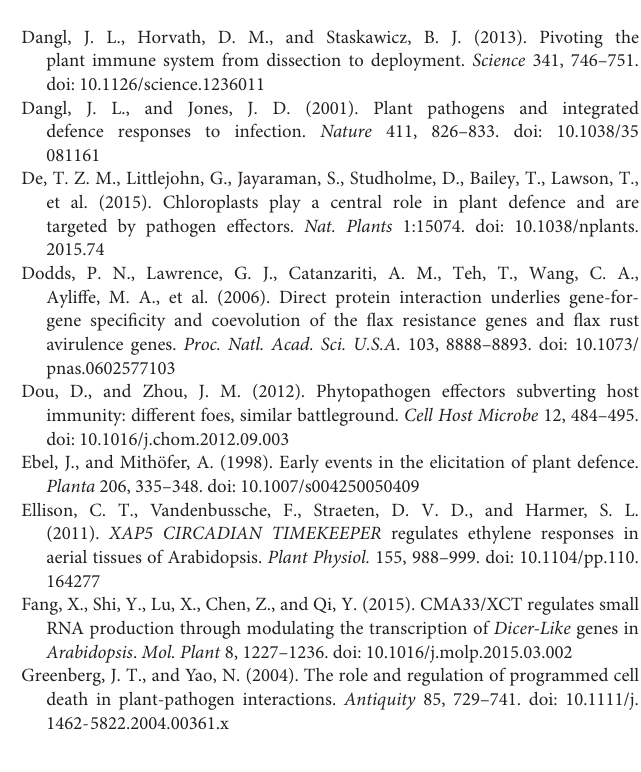
FIGURE S1 | Map-based cloning of b3-17. (A) Schematic graph shows map-based cloning of the b3-17 mutant gene. A horizontal black bar represents chromosome 2. Markers were shown above the bar and their physical locations on the chromosome were shown by numbers below the bar. BAC, bacterial artificial chromosome. (B) Schematic gene structure of XCT ( At2g21150 ). The exons and introns in the coding region of the candidate gene were shown as black boxes and gray bars, respectively. (C) Alignment of the cDNA of XCT from b3-17 with wild type XCT cDNA and genome DNA shows the altered splice in the mutant (red box). (D) Alignment of the putative amino acid (AA) residues between b3-17 and the wild type XCT (AT2G21150) shows the induction of stop site after two AA substitutions (red ∗ in the red box). FIGURE S2 | Quantitative analyses on the relative mRNA level of XCT. (A,B) Relative mRNA level examined by quantitative RT-PCR in the representative knocked-down (A) and overexpression lines (B) . Error bars indicate SD ( n = 3). Student’s t -test was carried out to determine the significance of difference between Col- gl and the indicated transgenic lines. Asterisk ∗ and ∗∗ indicated significant difference at P ≤ 0.05 and P ≤ 0.01, respectively. Similar results were obtained in two